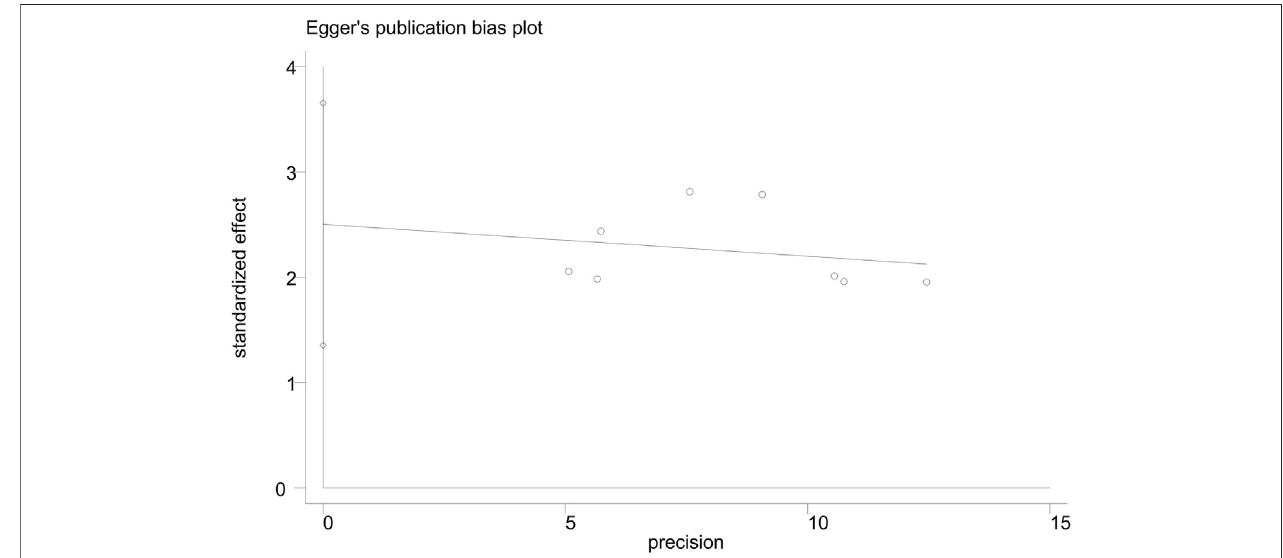
FIGURE 10 | Egger ’ s test of the overall response rate.